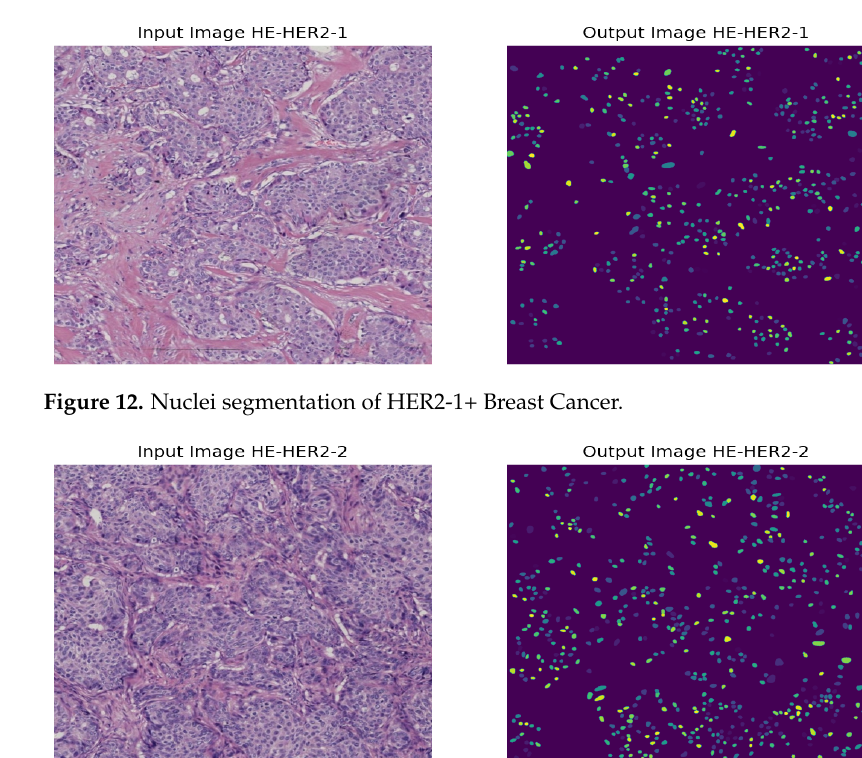
Figure 11. Nuclei segmentation of HER2-0 Breast Cancer.